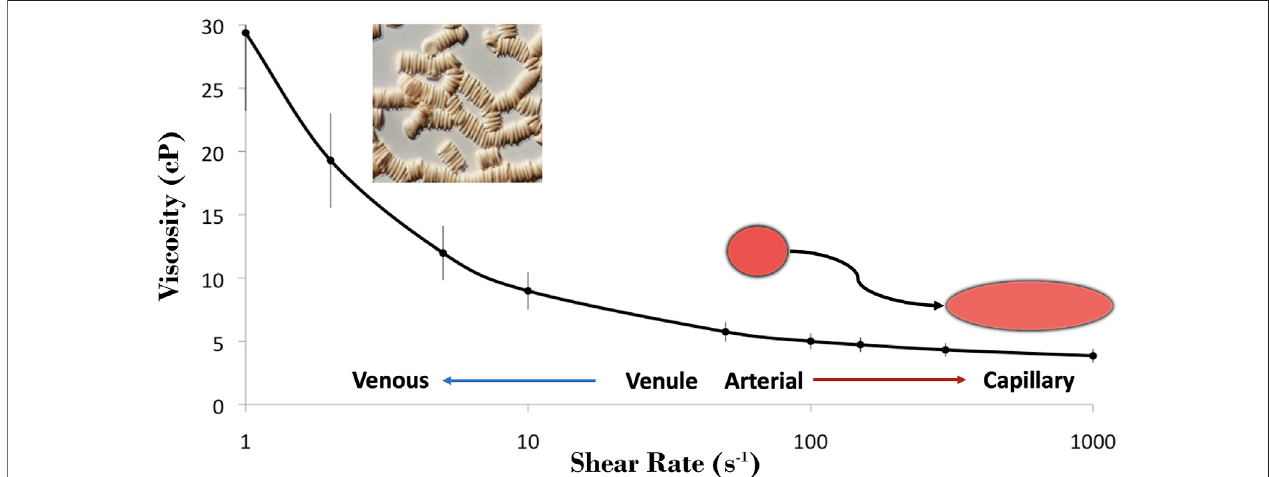
FIGURE1| Bloodis ashear-thinning fl uid,where itis mostthick within the venousnetworkwithlower shear and itbecomesprogressivelythinnerunderthe higher shear regions of the arterial network and microcirculation. The tendency for RBC to cluster (i.e., aggregate; micrograph) is the primary determinant of blood viscosity at low shear, and the dispersion of these clusters aids in dramatically decreasing blood viscosity with increasing shear. The shear thinning observed at > 100 s − 1 may be attributed to the unique capacity of RBC to deform from their resting discocyte shape to hydrodynamically favorable morphologies, thus reducing the internal resistance of